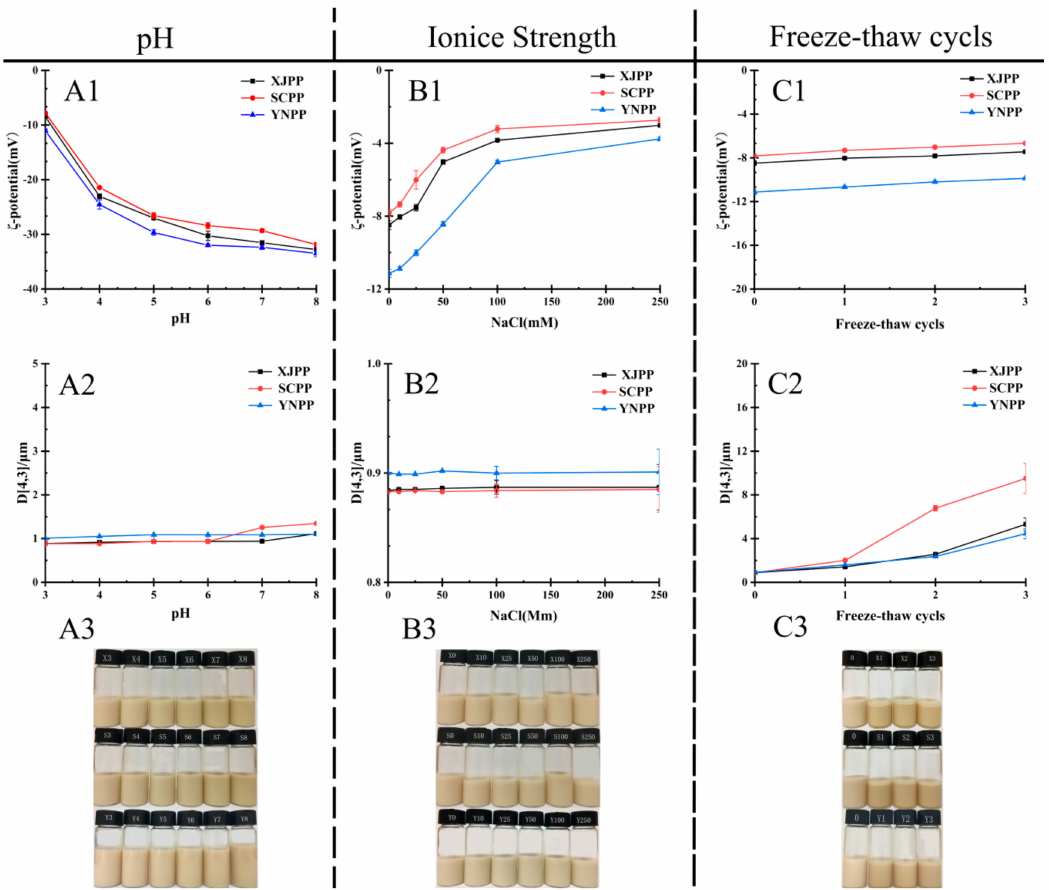
Figure 4. Influence of pH on emulsion ξ -potential ( A1 ), average particle size ( A2 ), emulsion stability ( A3 ), Na + on emulsion ξ -potential ( B1 ), average particle size ( B2 ), emulsion stability e ff ect ( B3 ), freeze-thaw cycles on emulsion ξ -potential ( C1 ), average particle size ( C2 ) and emulsion stability ( C3 ). The emulsion was observed after seven days of storage at room